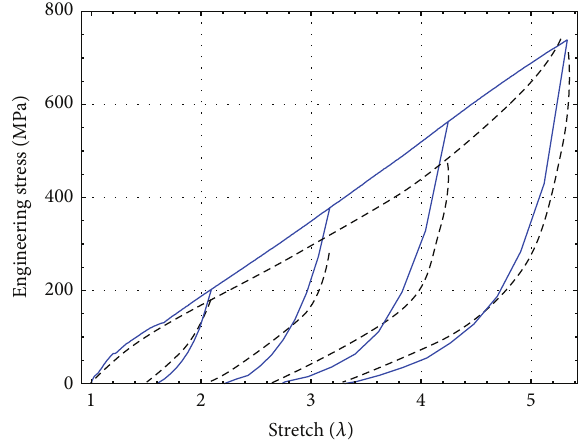
Figure 2: Engineering stress-stretch data for MonoPlus sutures compared with theoretical predictions of the nonmonotonous amended average-stretch, full-network model for which 𝜇 = 100 MPa, 𝑁 = 20 , 𝑏 = 0.45 , and 𝐶 = 0.0065 MPa. The dashed black lines represent theoretical predictions, and the blue solid lines describe experimental data.